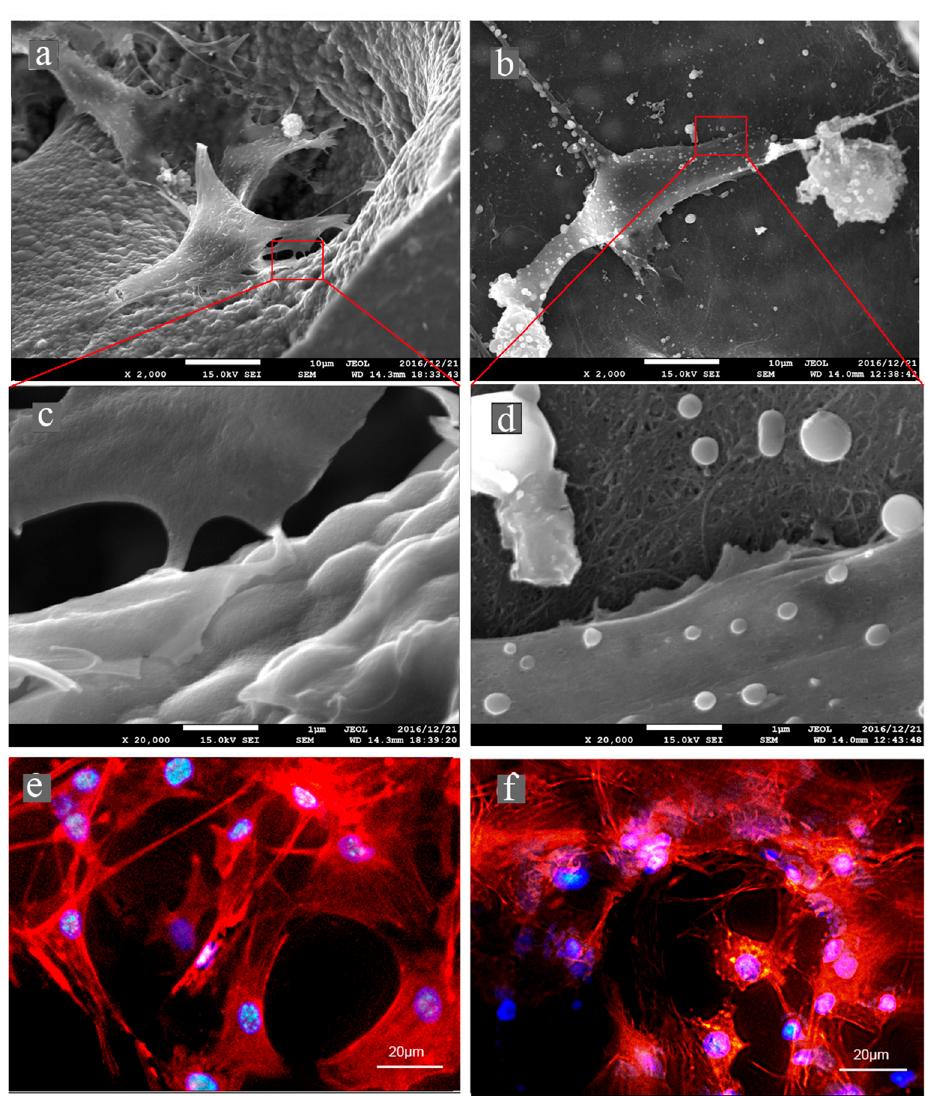
Figure 7. MC3T3 ‐ E1 cells spreading on IP ‐ CHA and CNTp scaffolds. Cells on ( a , c , e ) IP ‐ CHA or ( b , d , f ) CNTp. SEM images of ( a , c ) IP ‐ CHA and ( b , d ) CNTp. Original magnification is 2000× for ( a , b ) and 20,000× for ( c , d ). Cells labeled for actin filaments (red) and nucleus (blue) of ( e ) IP ‐ CHA and ( f ) CNTp.